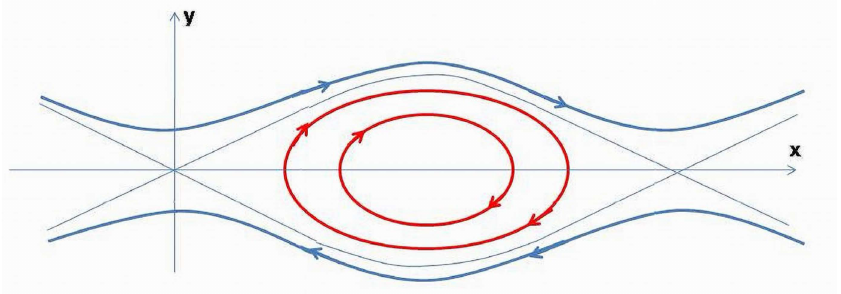
Figure 12. Sketch of fluctuations of the energy levels (entropy of the system) associated with quadratic function <h,h> = w 2 + x 2 − y 2 − z 2 . Dominance of the system-formation processes (negative entropy) shows fluctuations of the graph above and below asymptotes (blue), while dominance of the system- destruction processes (positive entropy) corresponds to the closed curves between asymptotes